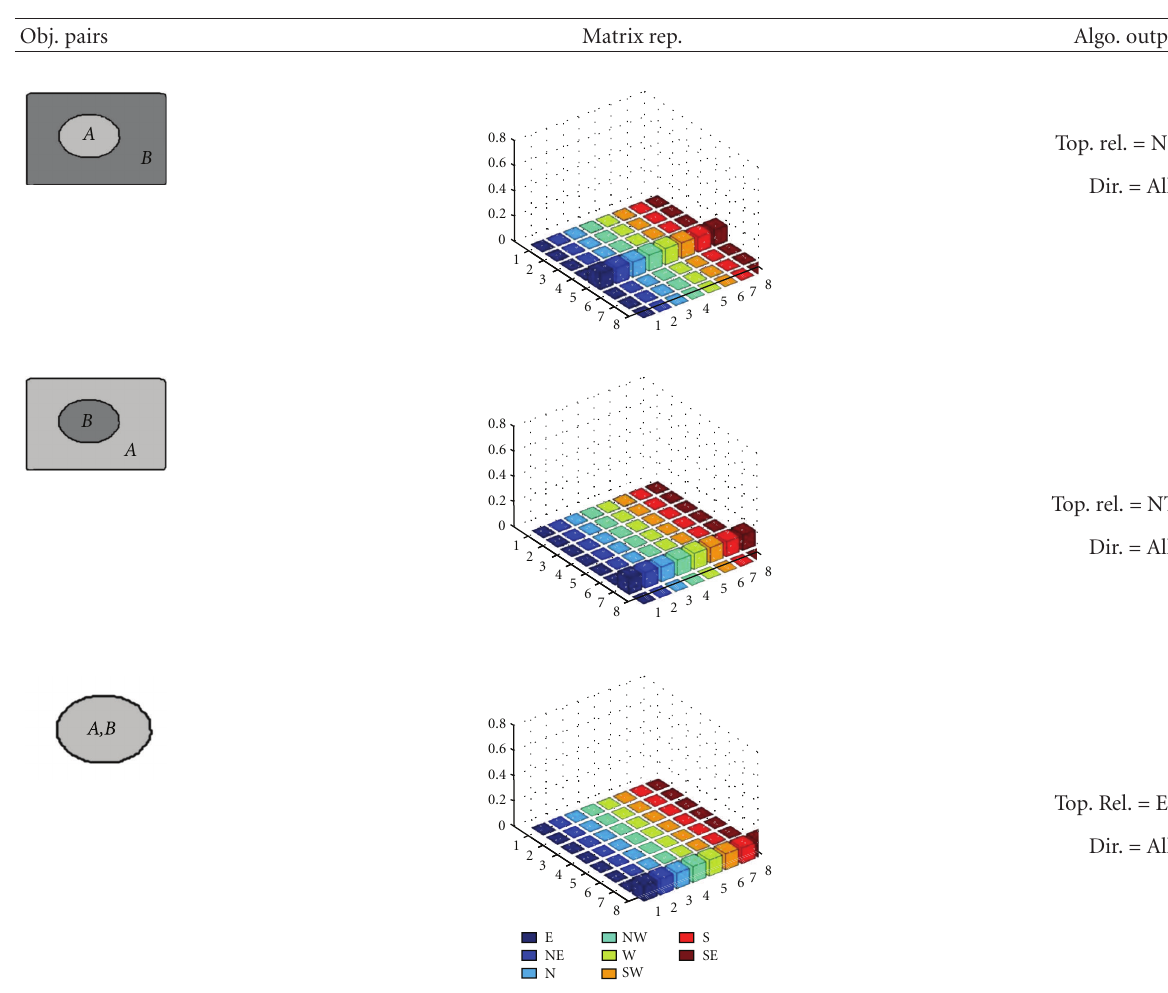
Table 7: Topological relations NTPP, NTPPI and EQ. Obj. pairs Matrix rep. Algo. output